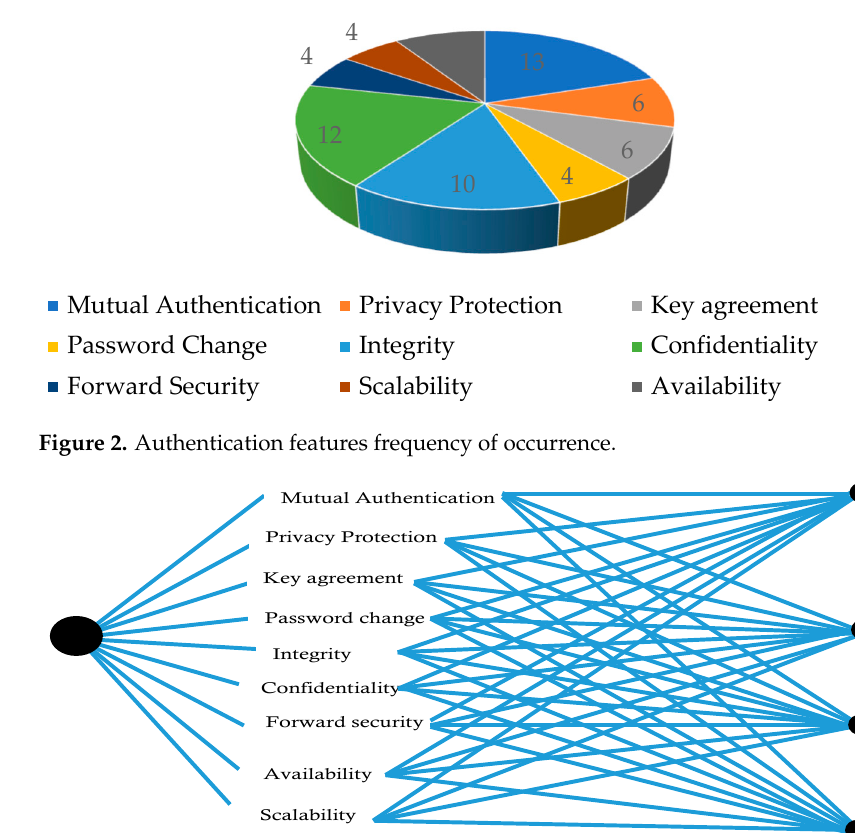
Figure 3. Hierarchical structure of authentication mechanisms and features.